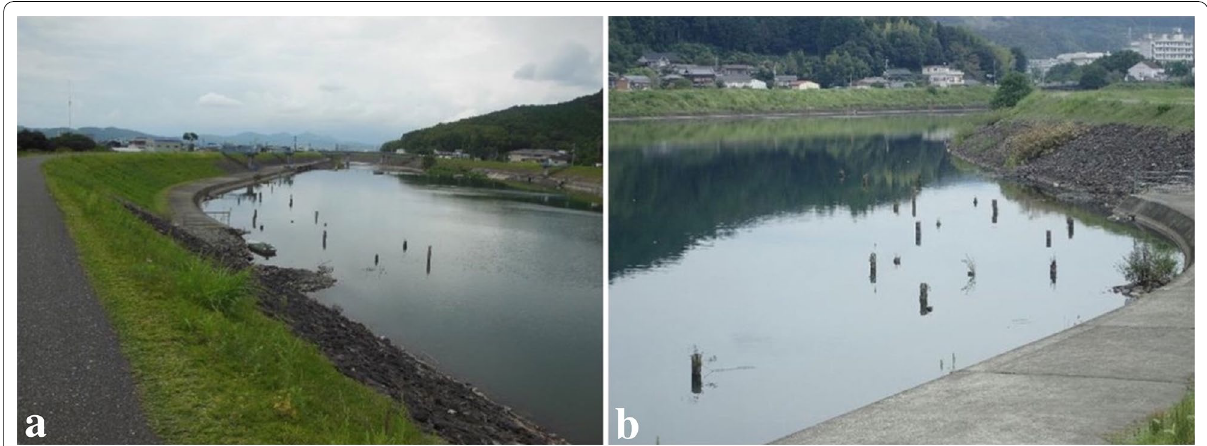
Fig. 1 A full view of river groynes using logs in the Kokubu River: a from the upstream side, b from the downstream